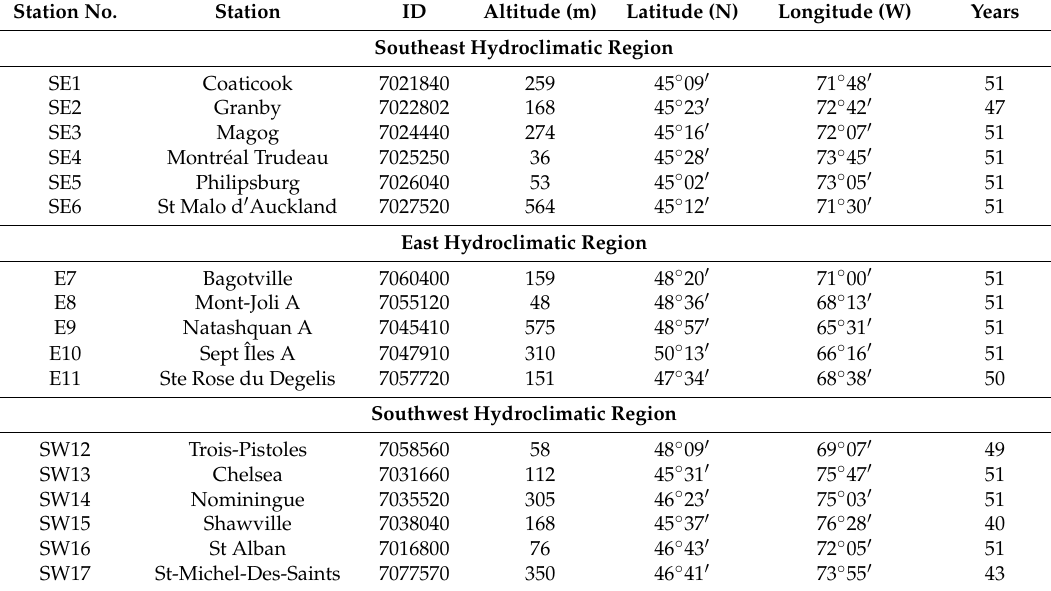
Table 1. Climatic